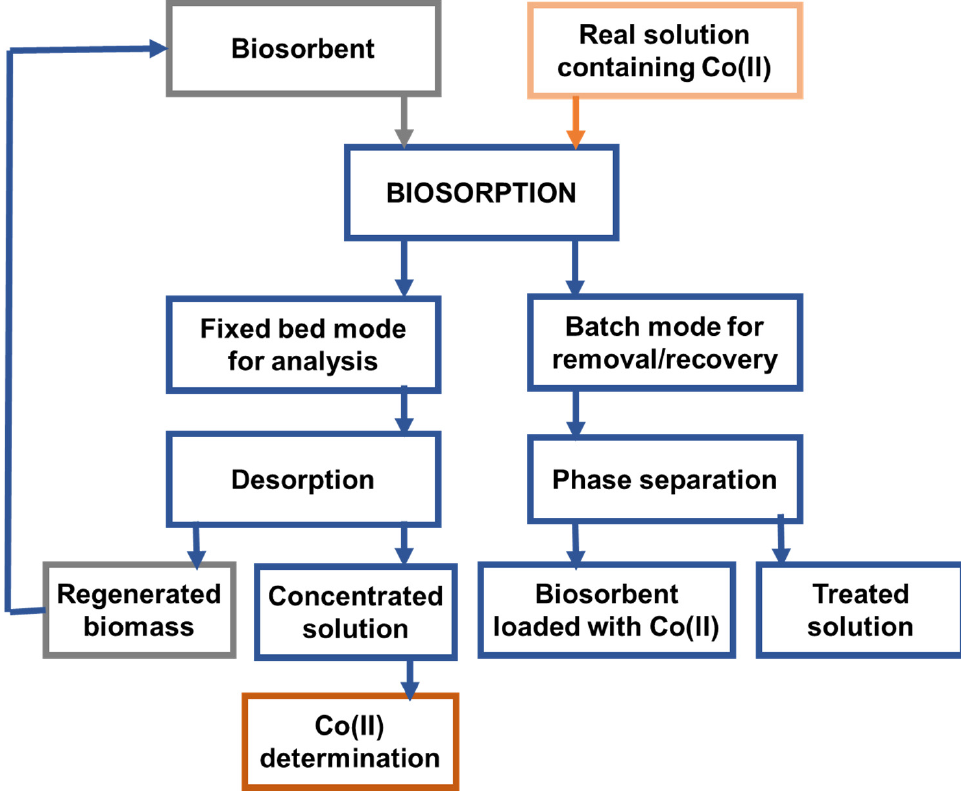
Figure 2. Schematic representation of the main biosorption-based procedures reported in the literature for removal, recovery, and analysis of Co(II) from actual matrices.